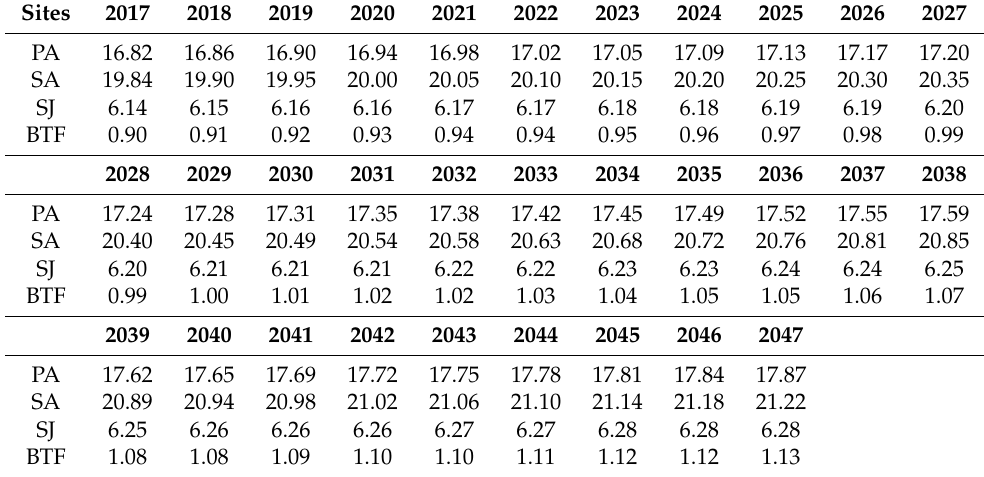
Table A2. Simulation of CO 2 emissions (kg ha − 1 yr − 1 ) over years at the four experimental sites in Ganghwa province of Korea.